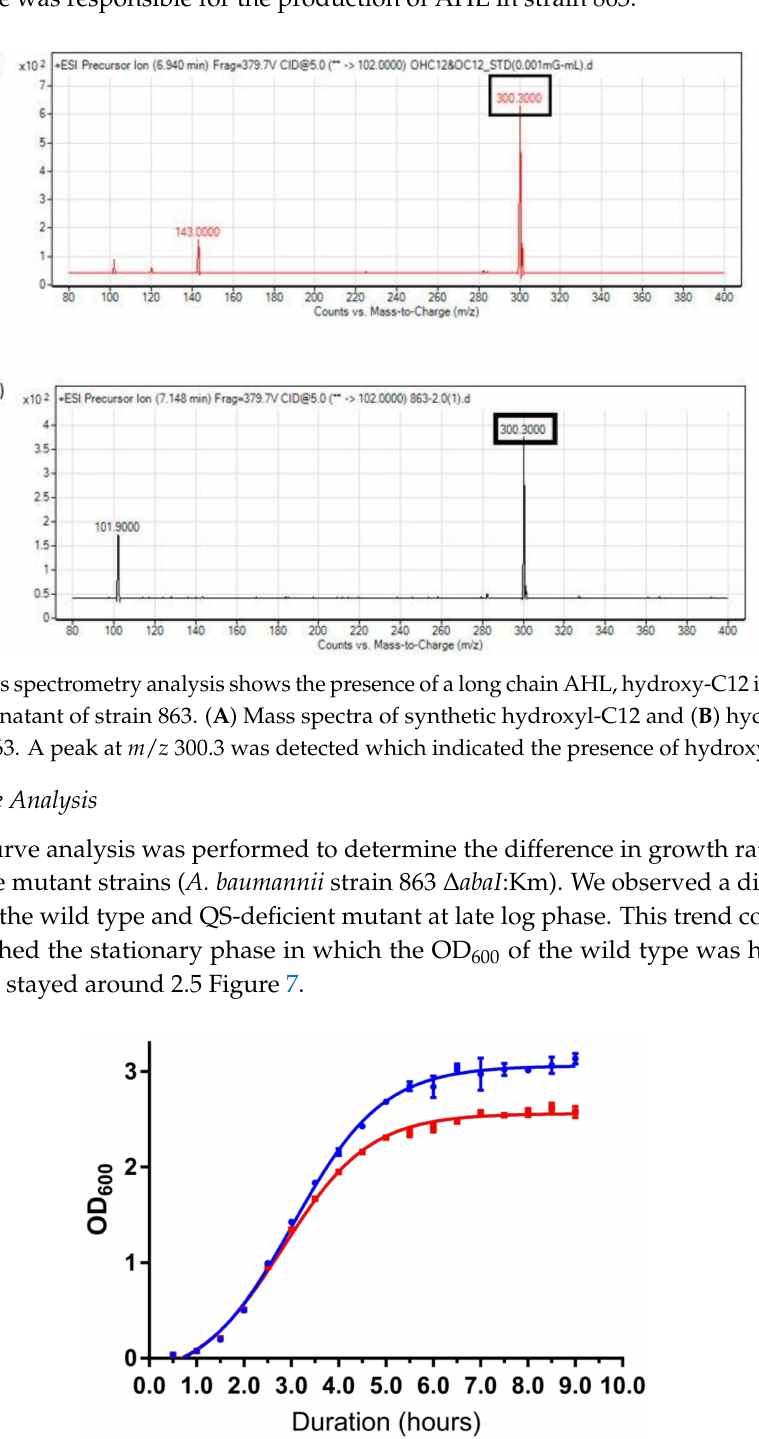
Figure 7. Growth curve analysis shows QS-deficient mutant suffered growth defect. Mutant strain (red line) has significantly lower cell density compared to the wild type (blue line). Data are presented as the mean ( ± S.E.) of three independent biological